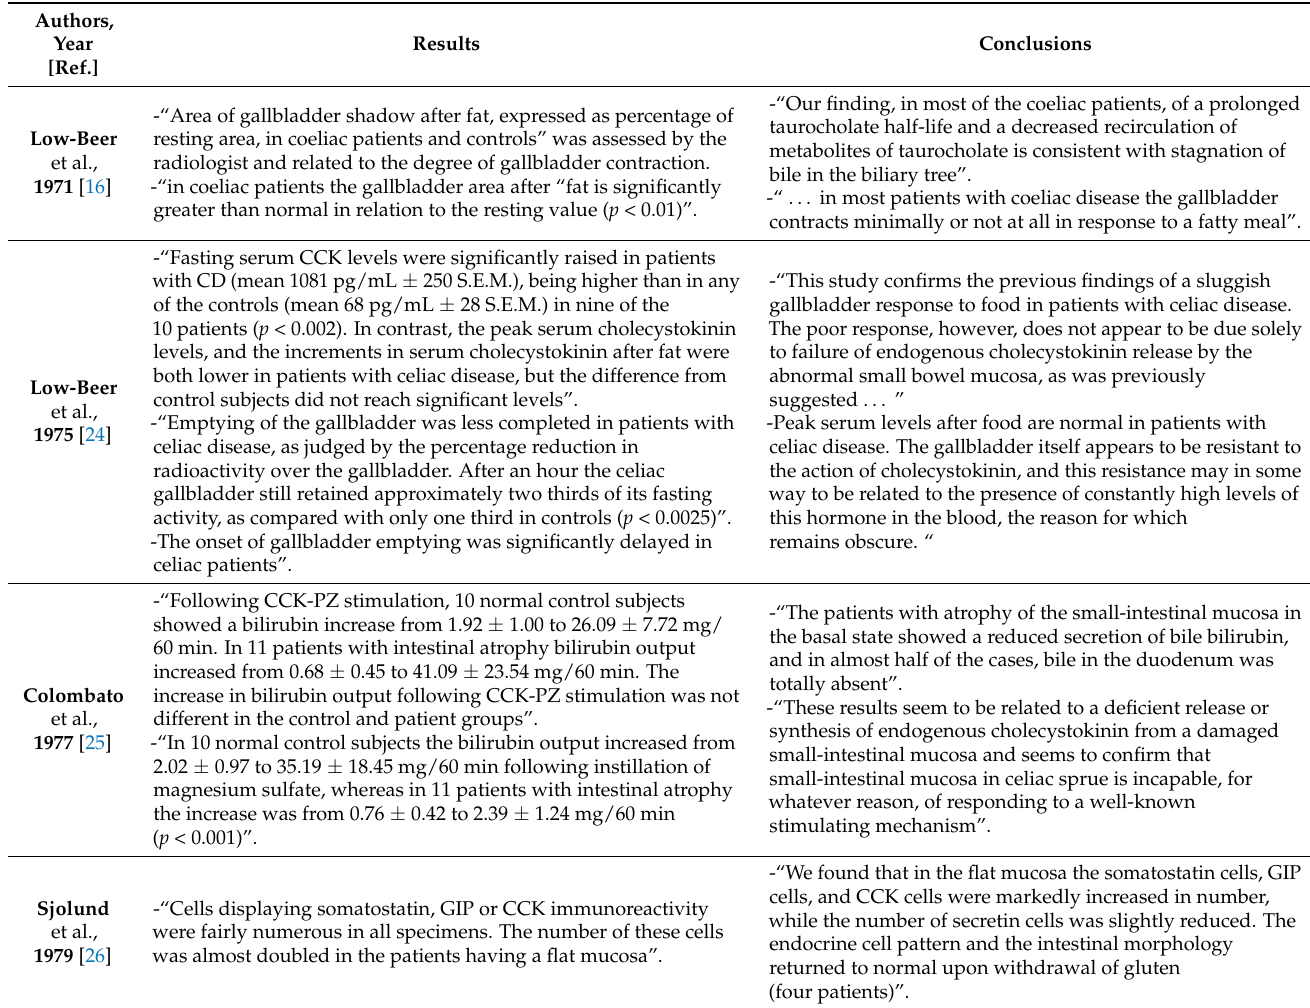
Table 2. Original text extracts from results and discussion/conclusion of the clinical studies investi- gating gallbladder functioning and regulation in CD